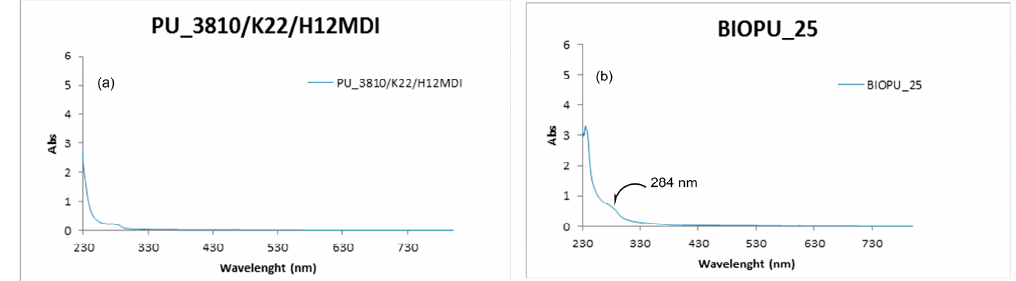
Figure 9. UV spectra for PU_3810/K22/H12MDI ( a ) and BIOPU_25 ( b ).